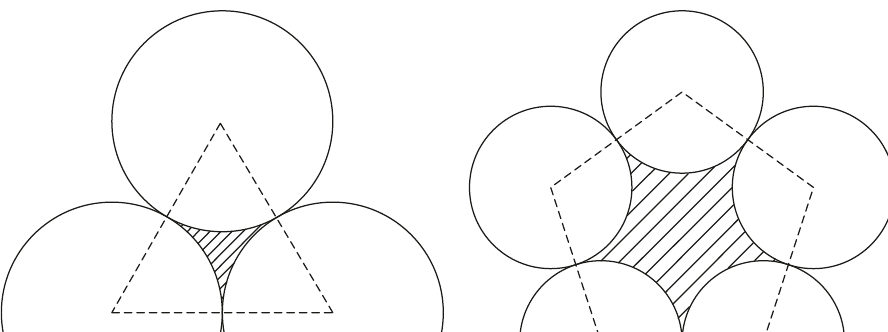
Figure 8: Projection of three-particle systems in YZ plane.